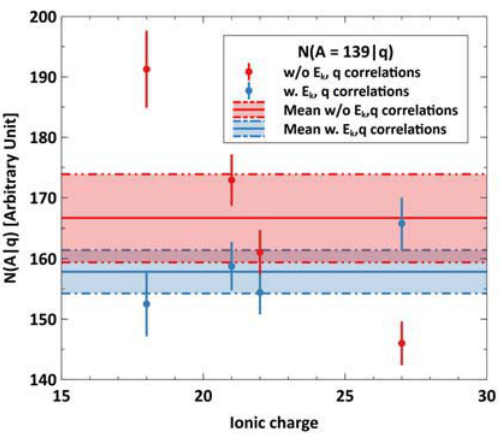
Figure 3. Estimation of the relative mass yield for A = 139 from the 241 Pu( n th , f ) reaction. Taking into account the correlation ( E k , q ) permits to reduce the uncertainty and the bias introduced by the classical procedure to estimate the fission mass yields on